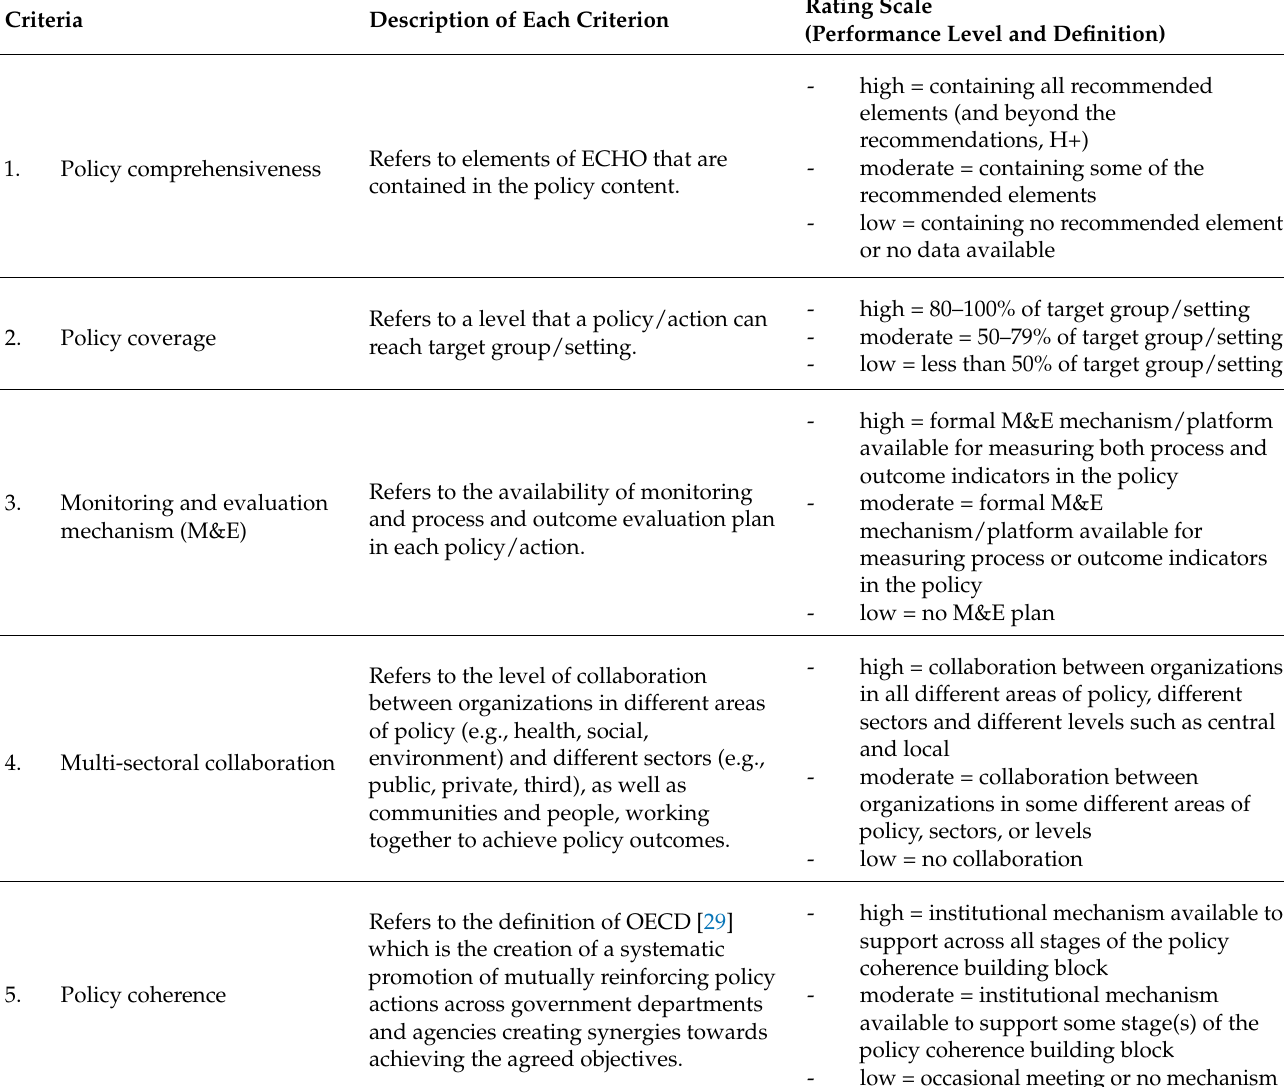
Table 1. Description of each criterion and their performance rating for analyzing policy implementation